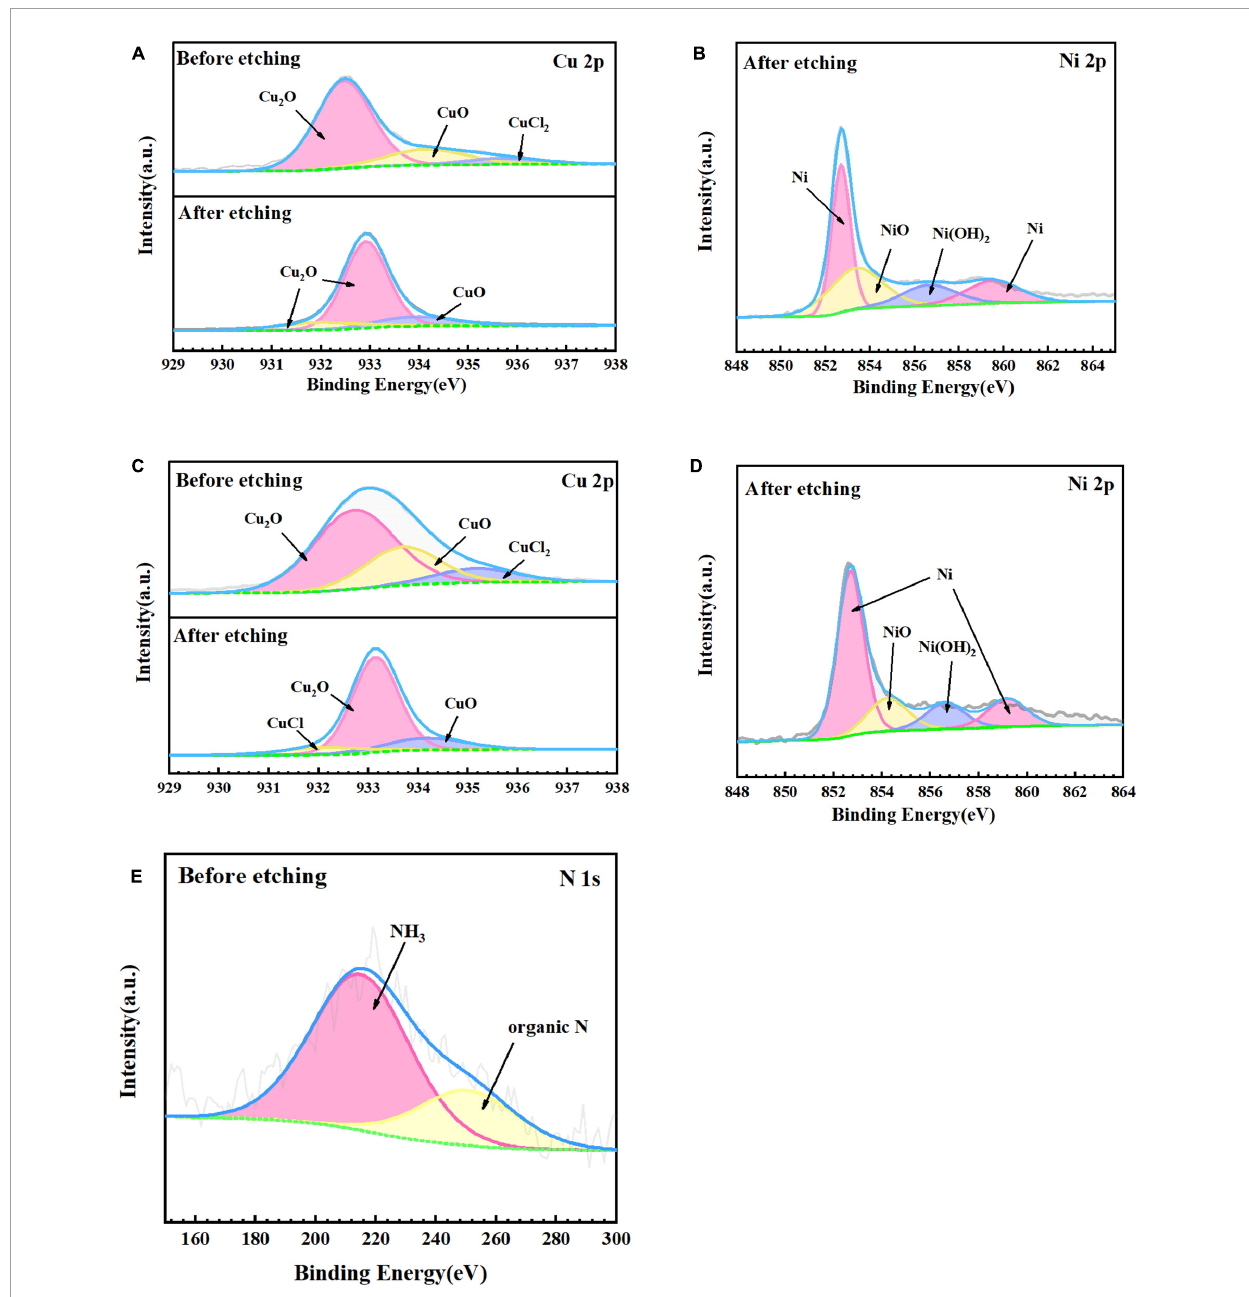
FIGURE7 X-ray photoelectron spectroscopy (XPS) fine spectra of B30 copper–nickel alloy before and after etching after immersed in different media for 21 days: abiotic medium (A) Cu 2p and (B) Ni 2p; P. aeruginosa (C) Cu 2p, (D) Ni 2p, and (E) N